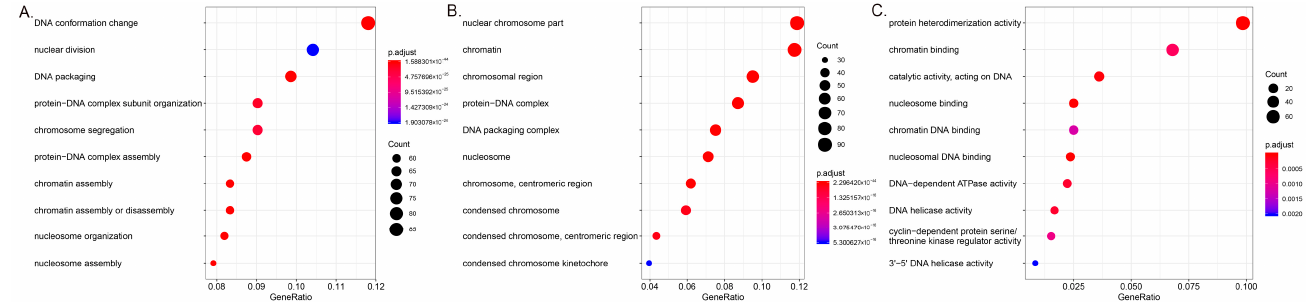
Figure 3. Gene Ontology enrichment analysis of upregulated mRNA between hepatocellular carci- noma and para-carcinoma tissues: ( A ) biological process, ( B ) cell component, ( C ) molecular func- tion.